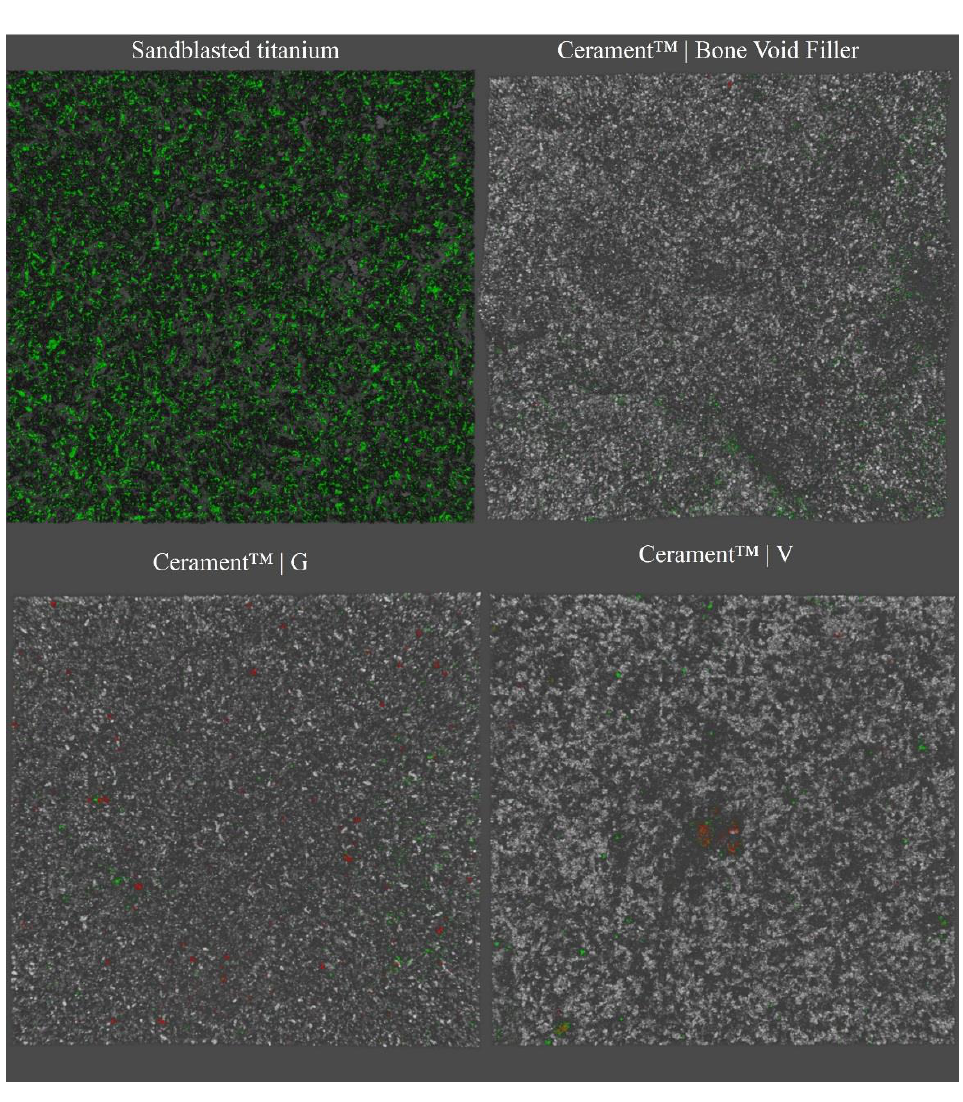
Figure 3. Representative confocal laser scan microscopy (CLSM) 3D images of sessile methicillin- resistant Staphylococcus aureus on ST, CBVF, CG and CV stained with Filmtracer™ LIVE/DEAD™ Biofilm Viability Kit. Magnification: 20x.